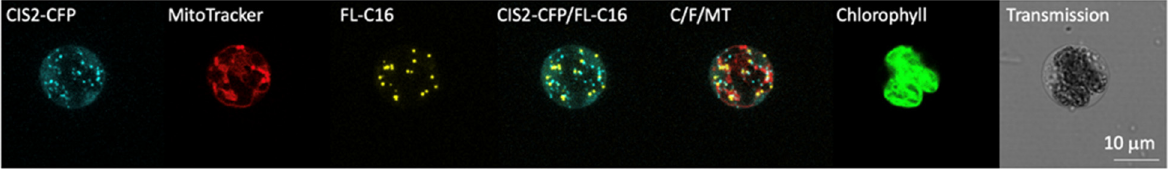
Figure 3. Exogenously added fatty acids are not accumulated in the peroxisomes or mitochondria. C. reinhardtii UVM4 expressing CIS2-CFP (cyan) was observed with confocal laser scanning microscopy after adding 20 µM FL-C16 (yellow), and 10 µM MitoTracker (red). Thirty optical sections of a 20 µm z-stack for each signal are projected into one image with their maximum intensity, respectively. Independent fluorescence channels are shown for CIS2-CFP, FL-C16, and MitoTracker as well as an overlay of these signals (C/F/MT). Chlorophyll fluorescence and transmission image are also shown. CIS2 is the citrate synthase, a key enzyme characterized to localize in algal peroxisomes where it participates in the glyoxylate cycle. Neither the signals of CIS2-CFP or MitoTracker co-localize with FL-C16. Chlorophyll autofluorescence is shown in green.